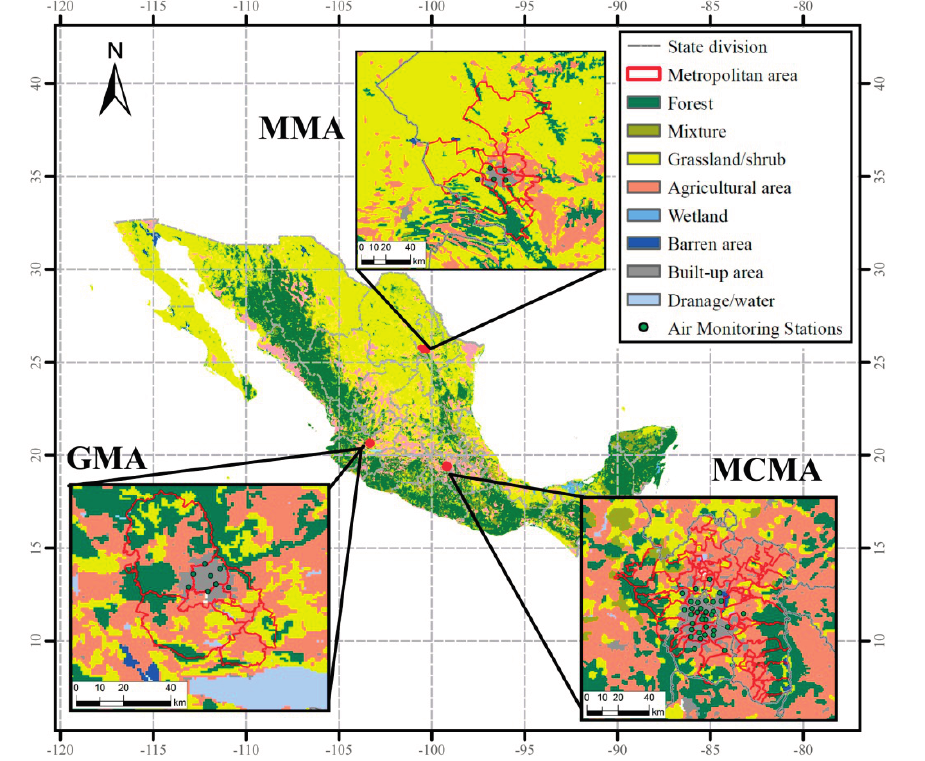
Figure 1. Locations of the three Mexican metropolitan areas, land use, territorial division, and locations of the air-monitoring stations.